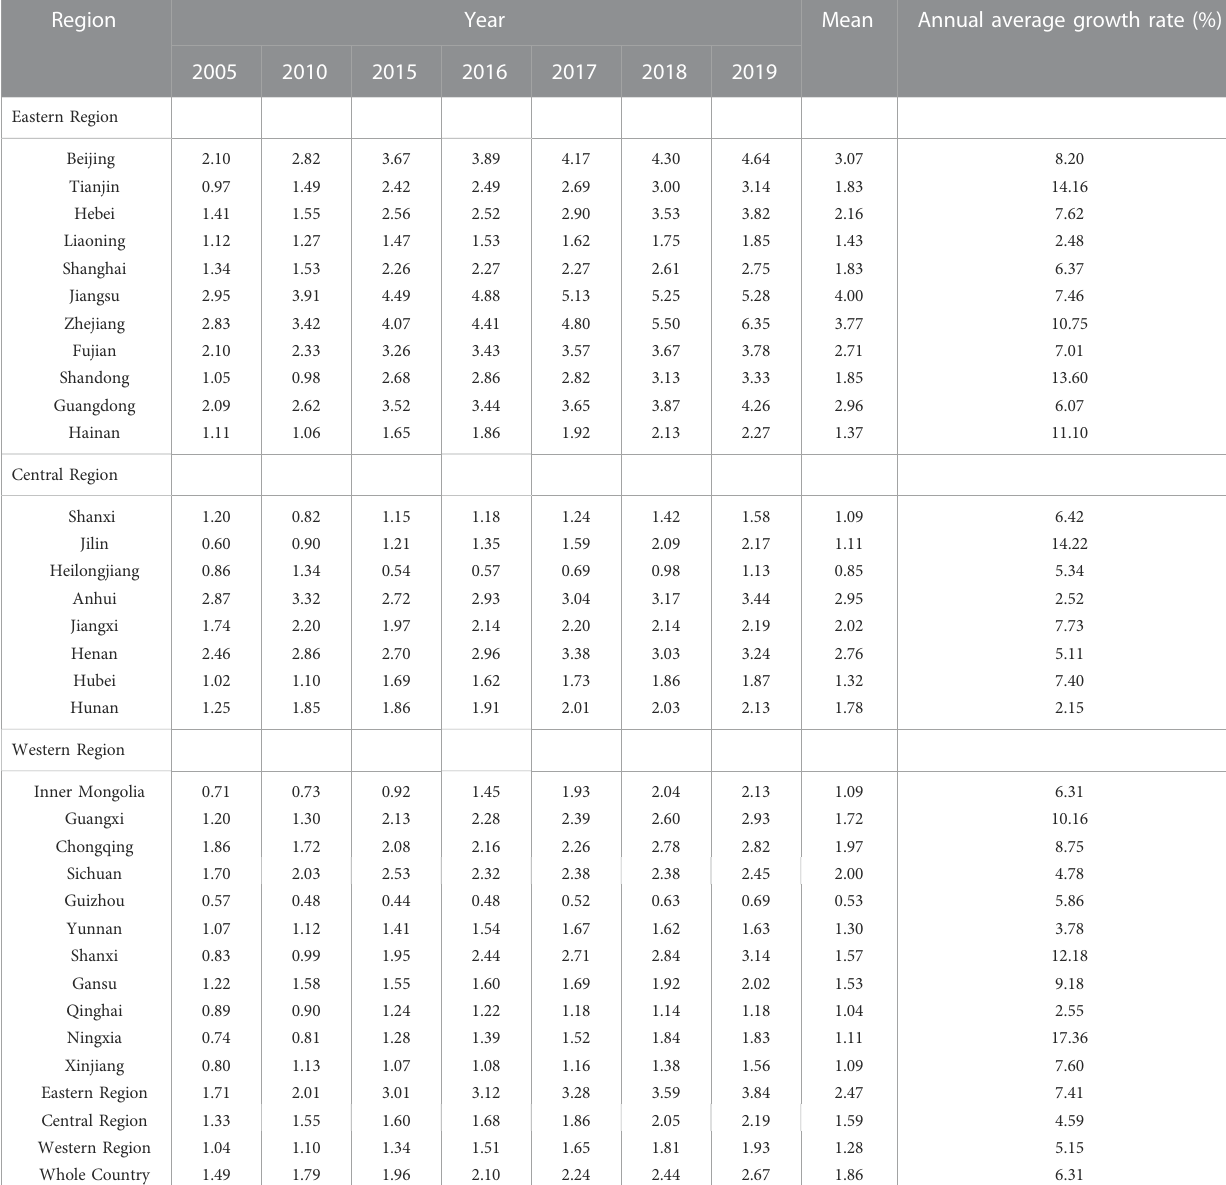
TABLE 1 The carbon productivity of the service industry in 30 China ’ s provinces, regions, and the whole country.